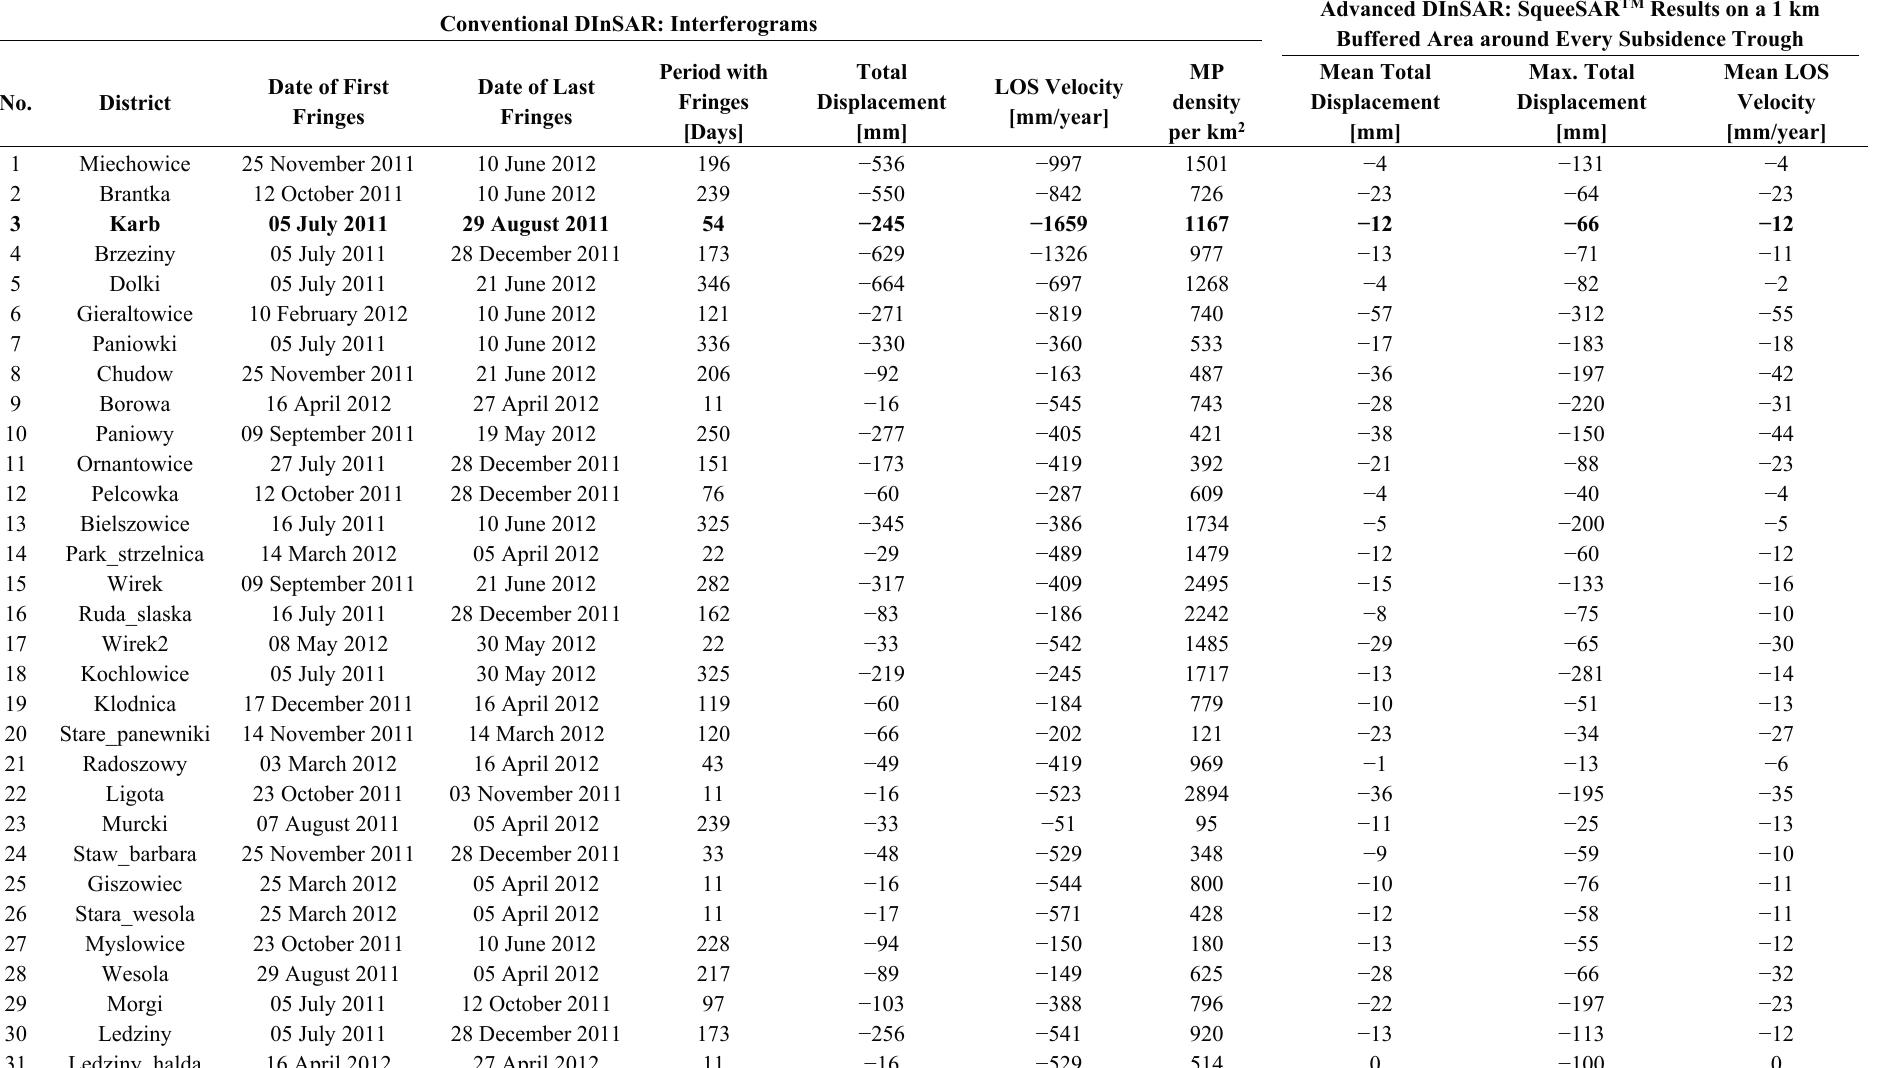
Table 4. Main characteristics of the subsidence troughs identified in the interferograms. In bold the area of the Karb settlement in Bytom. Conventional DInSAR: Interferograms